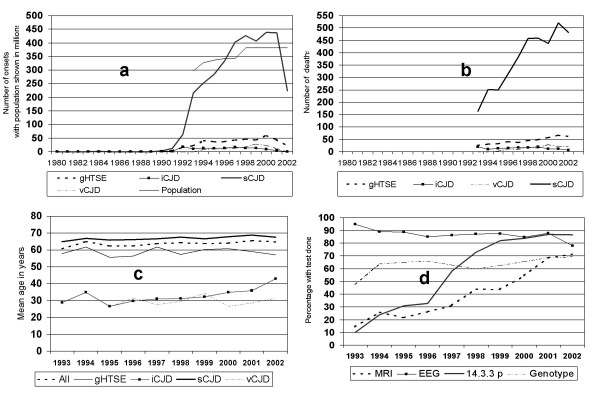
Variation across time for four major HTSE groups in: a) annual number of cases by year of clinical onset, with study population shown in millions; b) annual number of cases by year of death; c) annual average age at death and; d) proportion of cases, all entities, for whom diagnostic data were available in terms of EEG, 14.3.3 test in CSF, MRI and genotyping, by year of death